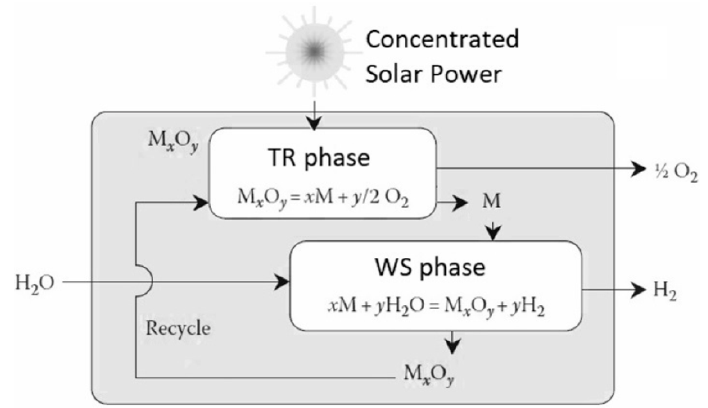
Figure 1. Basic scheme of a 2-step metal-oxide thermochemical process [18].